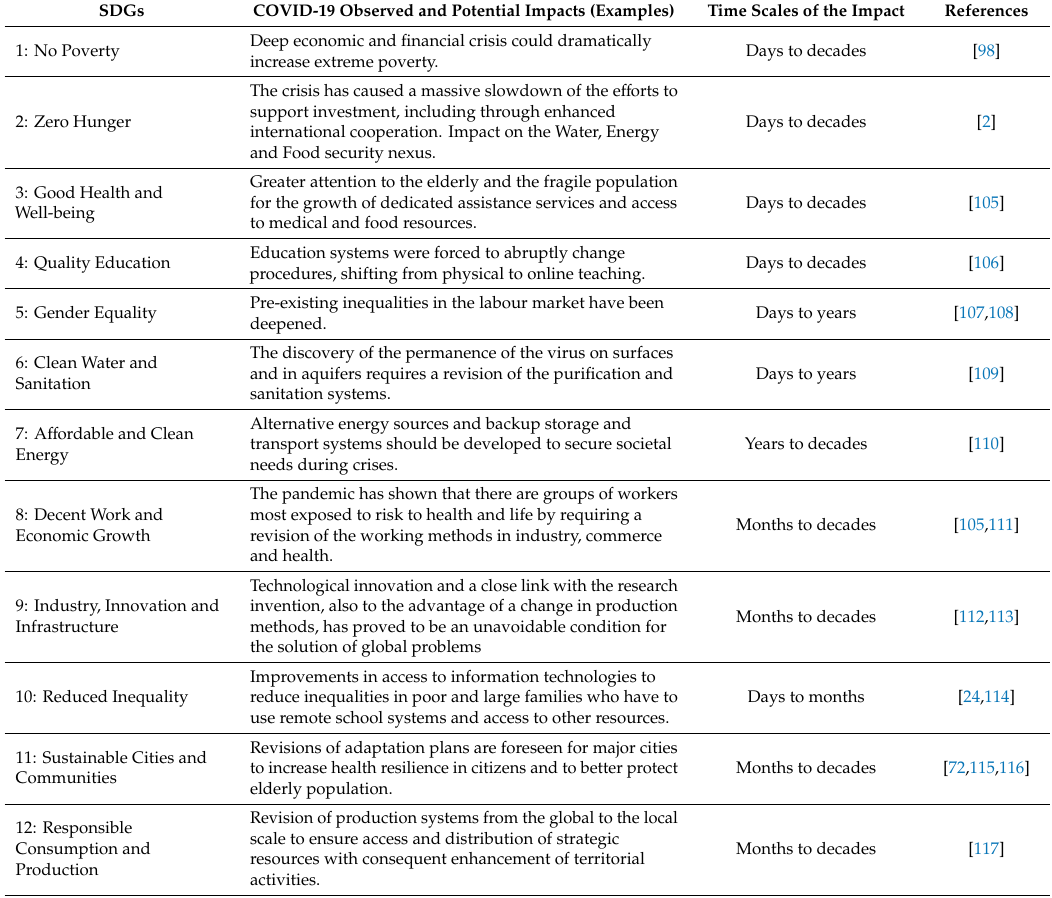
Table 1. Observed and estimated impacts of the COVID-19 pandemic on the Sustainable Development Goals (SDGs).